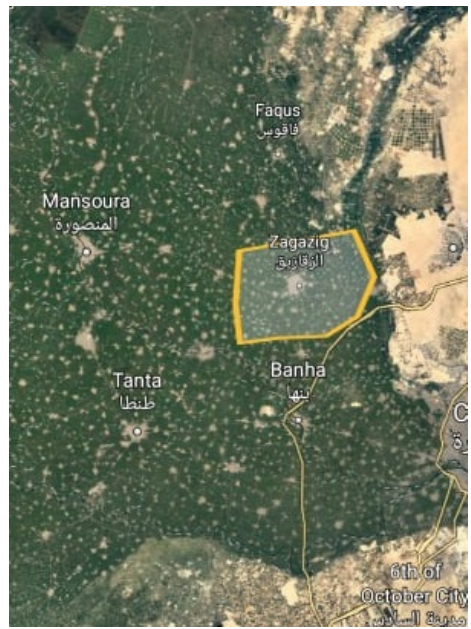
Energies 2020 , 13 , x FOR PEER REVIEW